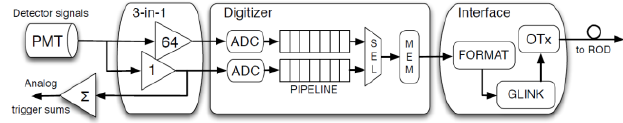
Fig. 2. Sketch of the current readout architecture in TileCal, representing in detail all the on-detector components